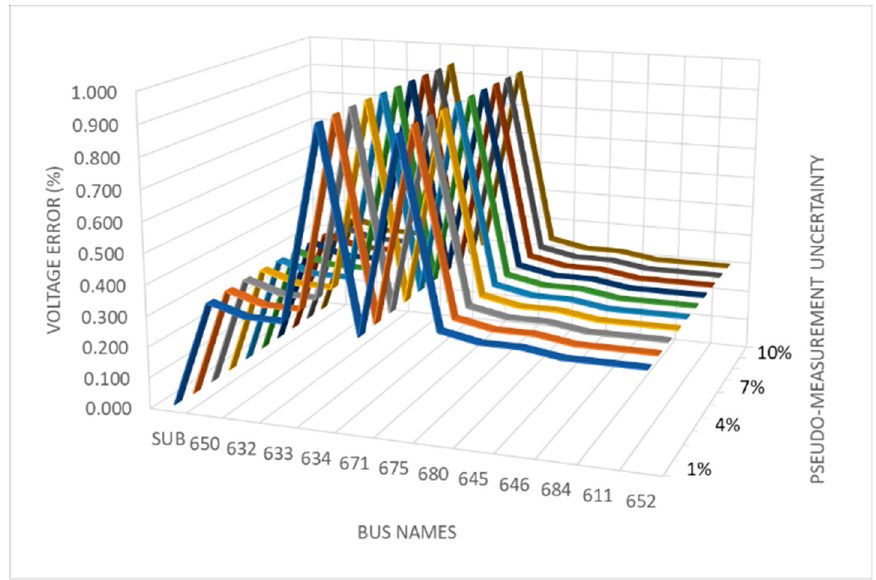
Figure 9. Influence of the pseudo-measurement uncertainty on the proposed state estimation performance.